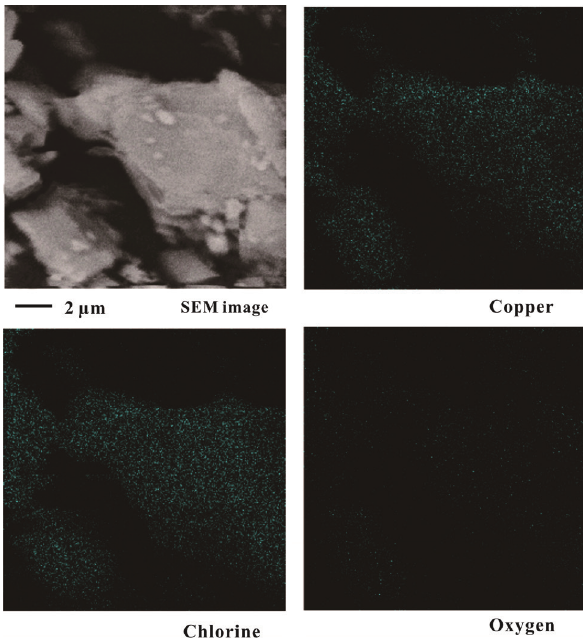
Fig. 11: SEM micrograph of raw materials and the Cu, Cl and O X-ray EDS mapping